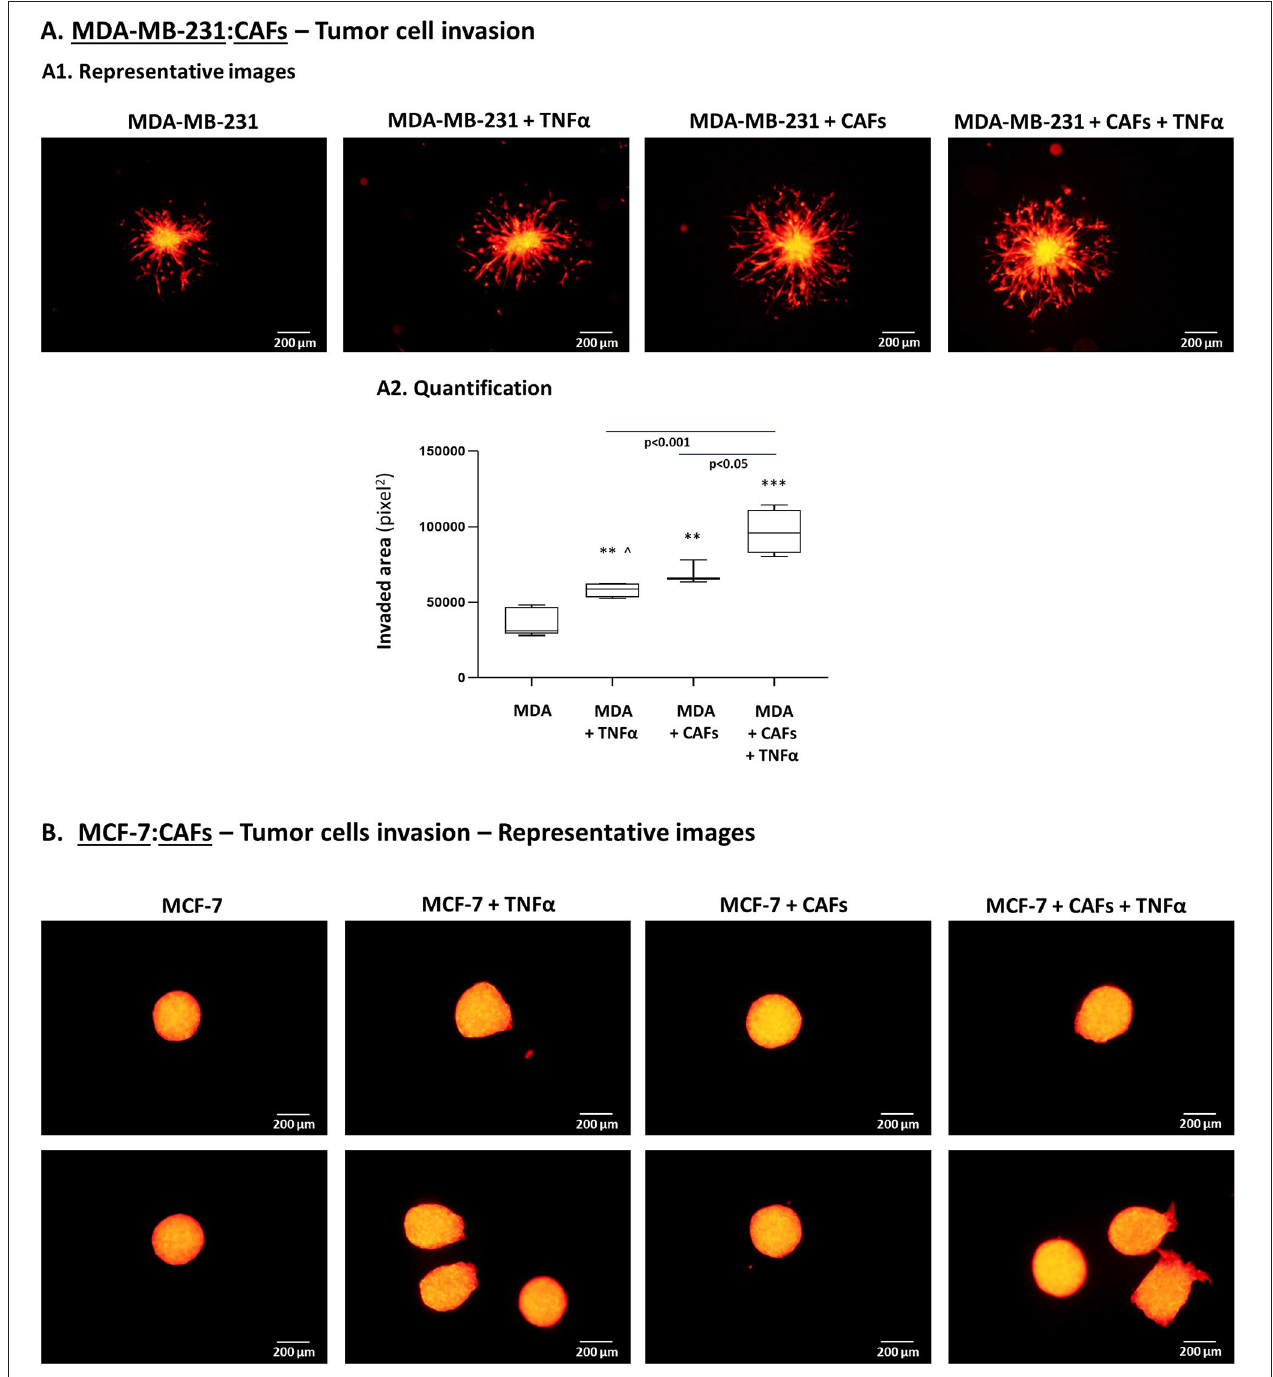
FIGURE 11 | TNBC cells but not luminal-A cells acquire elevated invasive properties upon “Contact” co-culturing with patient-derived CAFs in the presence of TNF α . (A) The Figure demonstrates similar experimental setup as in Figure 10 , performed herein with mCherry-MDA-MB-231 cells (“MDA”) and CAFs, using similar cytokine concentrations. [ ∧ Note: Possibly due to technical reasons (different matrigel batches) TNF α stimulation elevated tumor cell invasion in this setting but not in Figure 10 ]. (A1) Representative photos. Bar, 200 µ m. (A2) Invasion was quantified in multiple spheroids by ImageJ. *** p < 0.001, ** p < 0.01 for differences between invasion of tumor cells in different combinations, compared to the invasion of TNBC cells grown alone in spheroids. Photos and their quantifications are representatives of n > 3 independent experiments. (B) MCF-7 cells have undergone similar procedures to those described in Figure 10 , for 96h (TNF α 10ng/ml). Because invasion of MCF-7 cells out of the spheroids was minimal or absent, quantitation could not be performed. Instead, two representative photos out of many taken in n > 3 independent experiments, are provided for each treatment. Bar, 200 µ m.